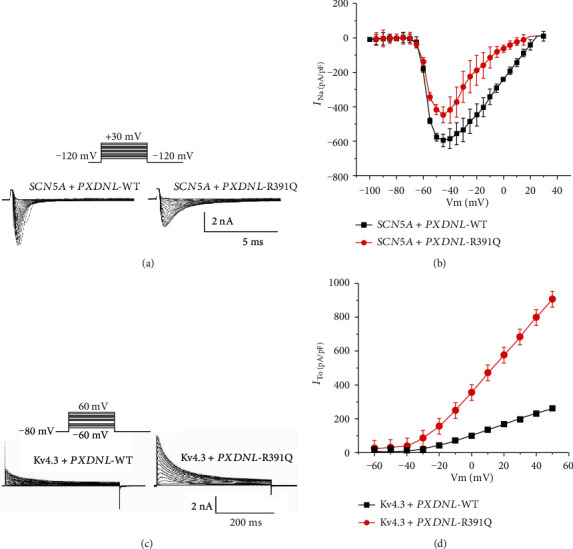
(a) Representative INa recordings from a WT and R391Q mutant in PXDNL cotransfected with SCN5A. I–V relation for WT and R391Q mutant in PXDNL cotransfected with SCN5A. The I-V relation was generated using same voltage clamp protocol described in Figure 5. A small reduction in INa density was noted with R391Q mutation. Representative Ito recordings from a WT and R391Q (a) mutant in PXDNL cotransfected with KCND3. Current recordings were obtained at test potentials between −60 and 50 mV from a holding potential was −80 mV. (c) I–V relation for WT and R391Q showing a significant difference in Ito magnitude at potentials above -20 mV.